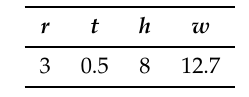
Table 2. Simulation results of the basic one-stage amplifier.